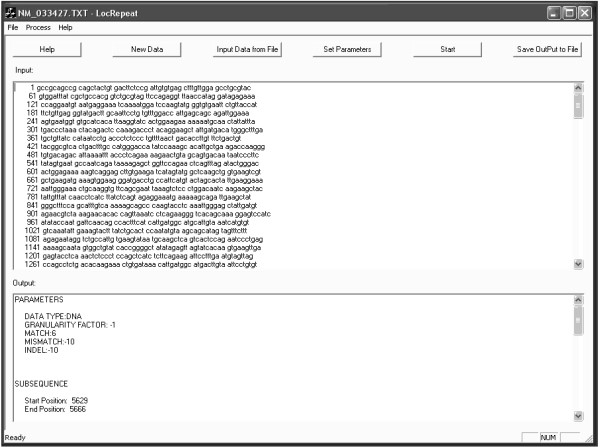
LocRepeat interface.